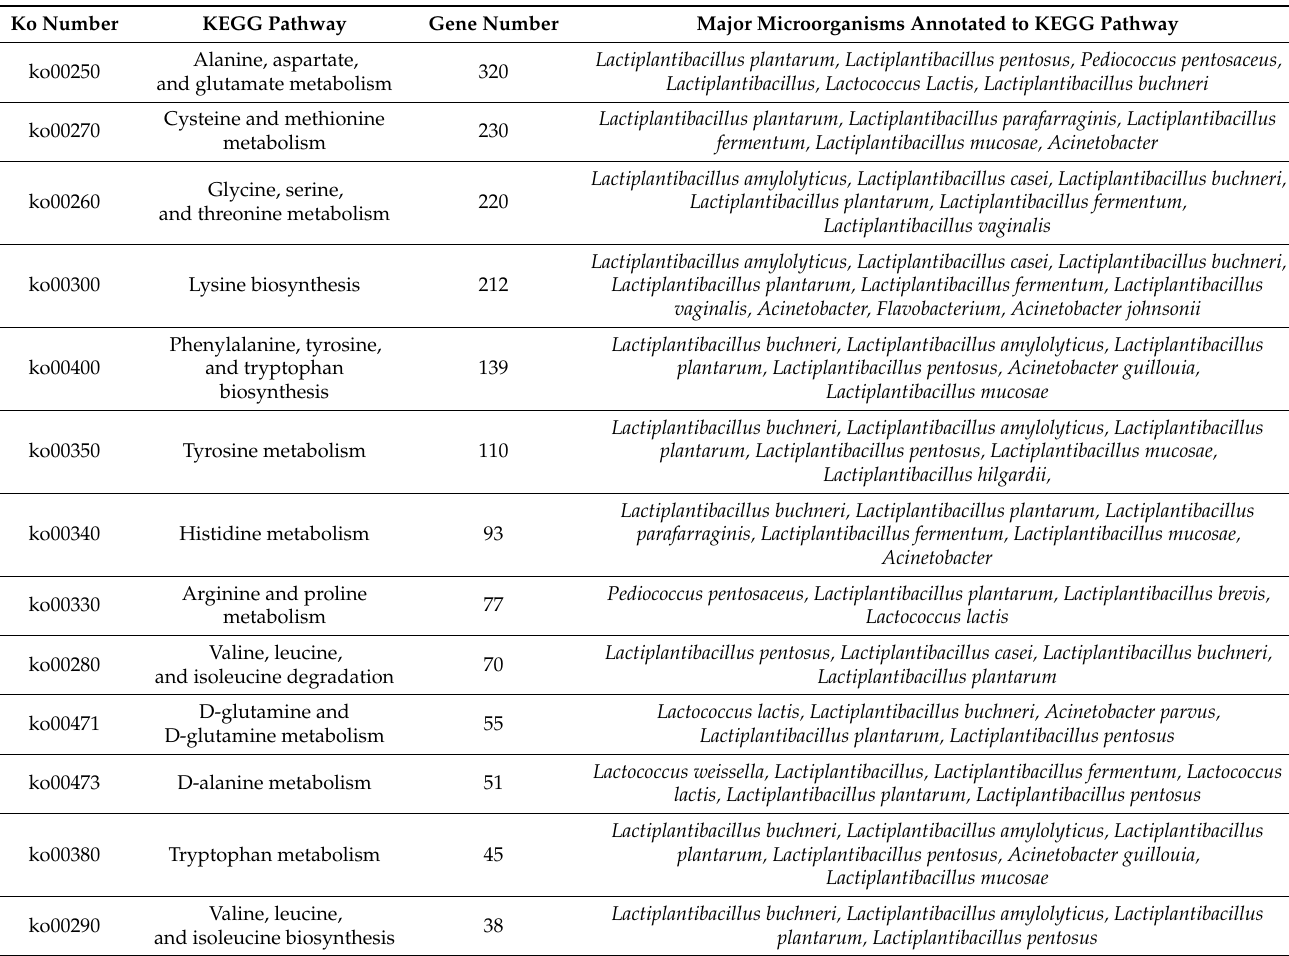
Table 5. Microorganisms associated with amino acid metabolism and their KEGG annotation pathway in suansun. Ko Number KEGG Pathway Gene Number Major Microorganisms Annotated to KEGG